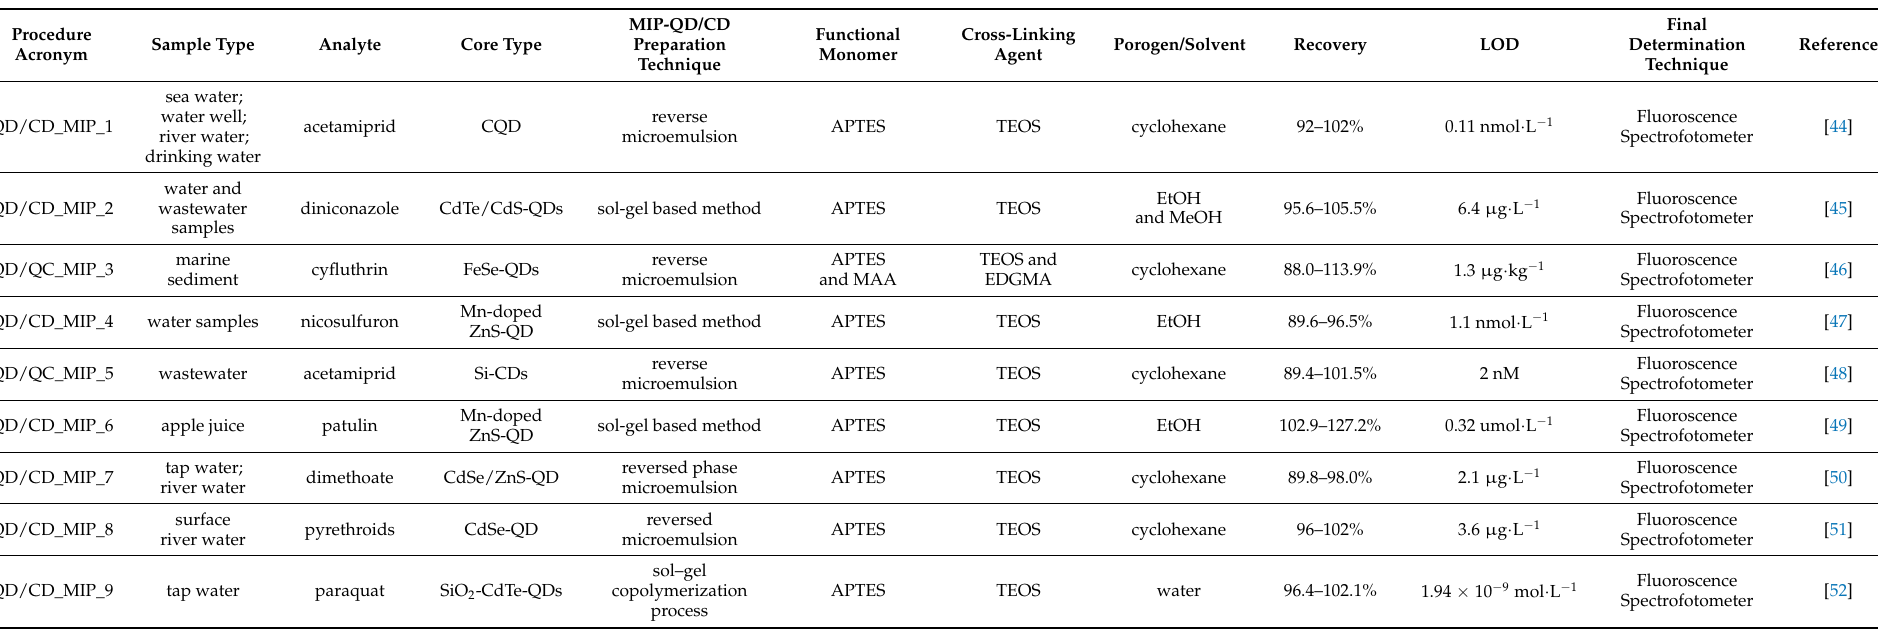
Table 4. Selected examples of introduction of nanomaterial-based MIPs (quantum and carbon dots) in analytical protocols for the specific recognition of pesticide residues in environmental and agricultural